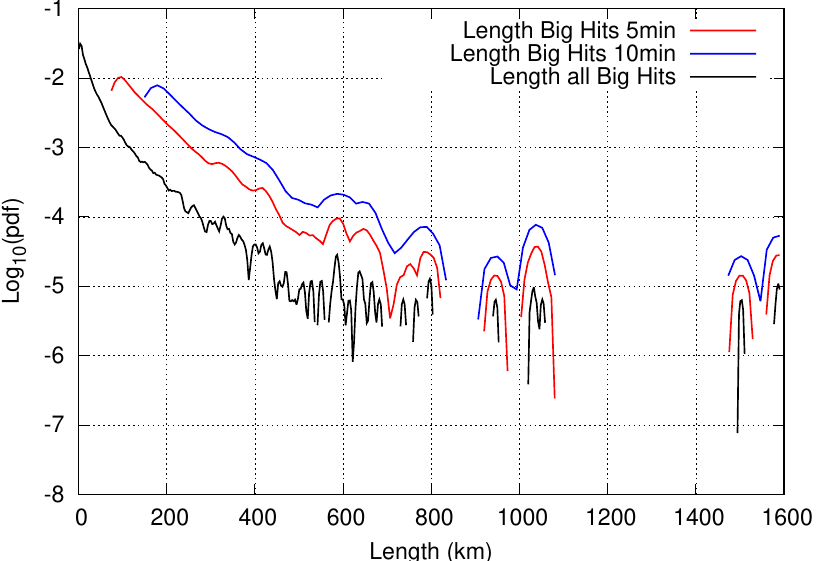
Figure 8. Path length distribution (pdf) for flight tracks with consecutive iRF ≥ 19Wm − 2 . The black curve shows the unconditioned distribution, which includes a lot of such strong events that are too short for rerouting an aircraft. The red and blue curves show the pdfs conditioned on a minimum path length or duration that an aircraft is flying under such conditions. Note the strong noise at large path lengths; the events that contribute there are essentially single cases.